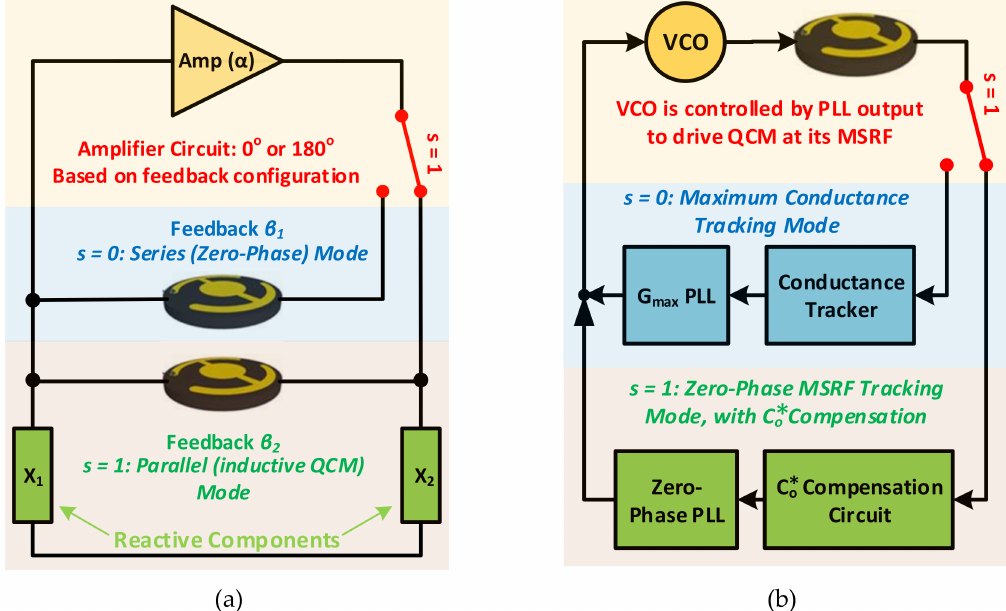
Figure 13. Generic block diagrams of oscillator based QCM electronic interfacing systems: ( a ) self-oscillating modes; ( b ) PLL based MSRF tracking